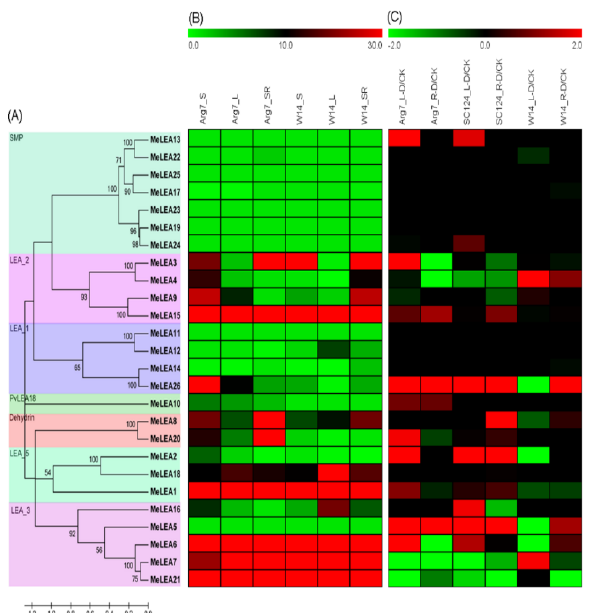
Figure 6. Expression patterns of MeLEAs in different tissues and in response to drought stress. ( A ) Evolutionary analysis of the LEAs from cassava; ( B ) Expression profiles of the MeLEAs in various tissues of Arg7 and W14. FPKM value is used to create the heat map with Mev 4.9.0 software. The color scale indicates the expression levels of MeLEAs . S, stem; L, leaf; SR, storage root. The FPKM value of the genes that was not covered in the transcriptomic datasets was set as “0”; and ( C ) expression profiles of the MeLEAs in leaves and roots of Arg7, SC124, and W14 after drought treatment. Log2-based fold changes was used to create the heat map with Mev 4.9.0 software. The FPKM value of the genes that were not covered in the transcriptomic datasets was set as “0”. Changes in gene expression are shown in color as the scale. L, leaf; R, root; D, drought treatment; CK, control check, showing leaf and root of cassava varieties under normal condition.